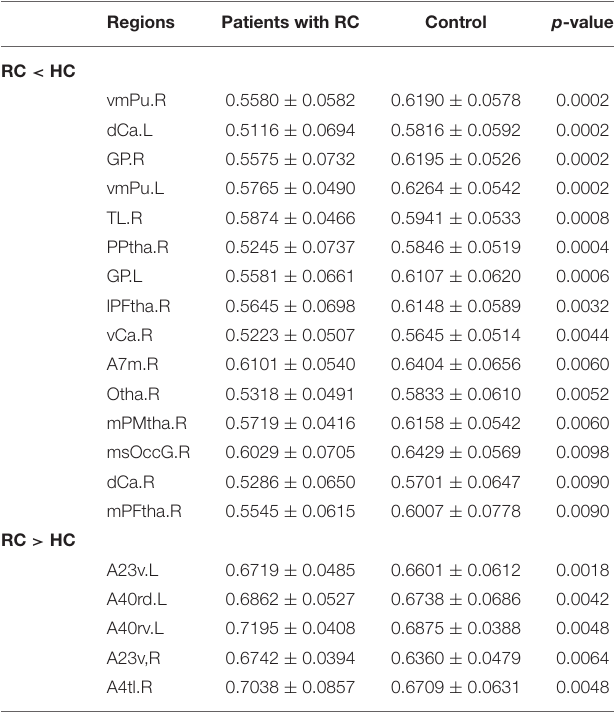
TABLE 2 | Brain regions with significant group effect in the nodal efficiency between patients with RC and HC for FN. Regions Patients with RC Control